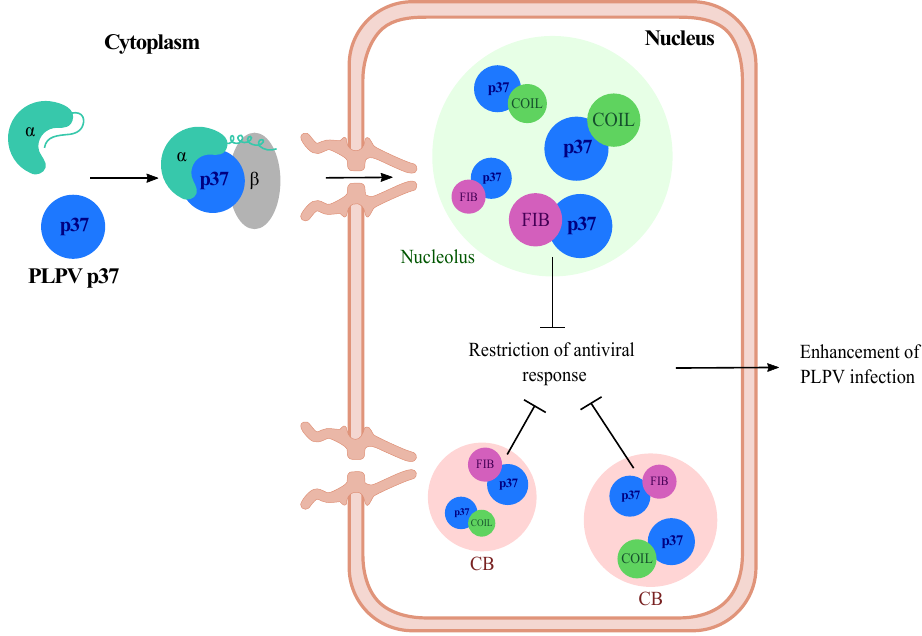
Figure 8. Proposed model reflecting the involvement of fibrillarin in an antiviral pathway targeted by PLPV p37. Protein p37 enters the nucleus assisted by an importin ( α , β )-mediated pathway (Pé- rez-Cañamás and Hernández, 2018) and reaches high accumulation at nucleolus and Cajal bodies (CB). In these subnuclear structures, p37 interacts with the signature proteins, coilin and fibrillarin. The latter interaction interferes with a fibrillarin-linked antiviral pathway, thus favouring PLPV in- fection.